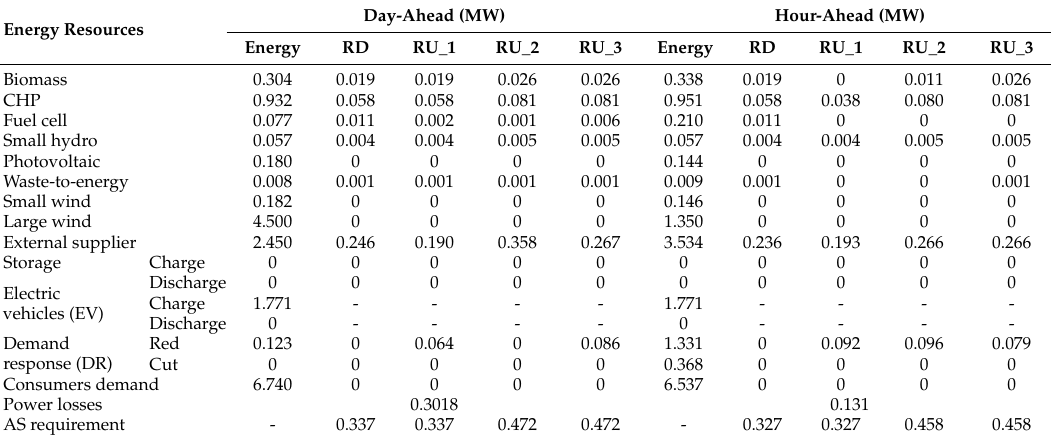
Table 3. Energy and reserve scheduling on hour 10 for day-ahead and hour-ahead stage.